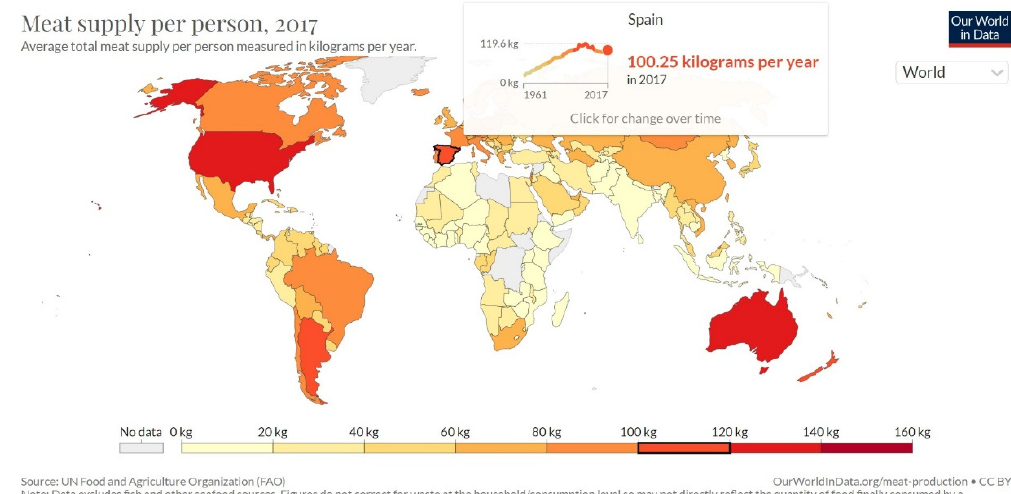
Figure 8. Meat supply per person and per year in Spain. Adapted from Ref. [22].